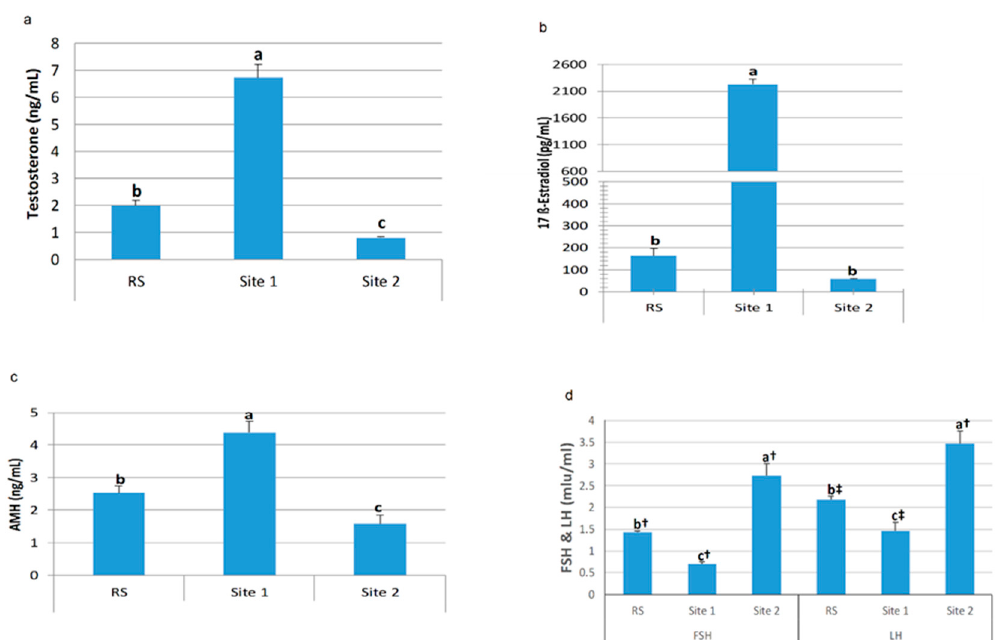
Figure 4. Testosterone ( a ), 17 β -estradiol (E2) ( b ), anti-Mullerian hormone (AMH) ( c ), follicle-stimulating hormone (FSH) and luteinizing hormone (LH) ( d ) serum hormonal analysis of Nile tilapia collected from different sampling sites. Data are presented as the mean of 10 fish ± standard error of mean (SEM). Values with a different letter superscript indicate a significant difference between sites ( p < 0.05 , one-way ANOVA). Values with a different dagger superscript indicate a significant difference between FSH and LH levels in the same site ( p < 0.05 , independent t -test). RS = control.